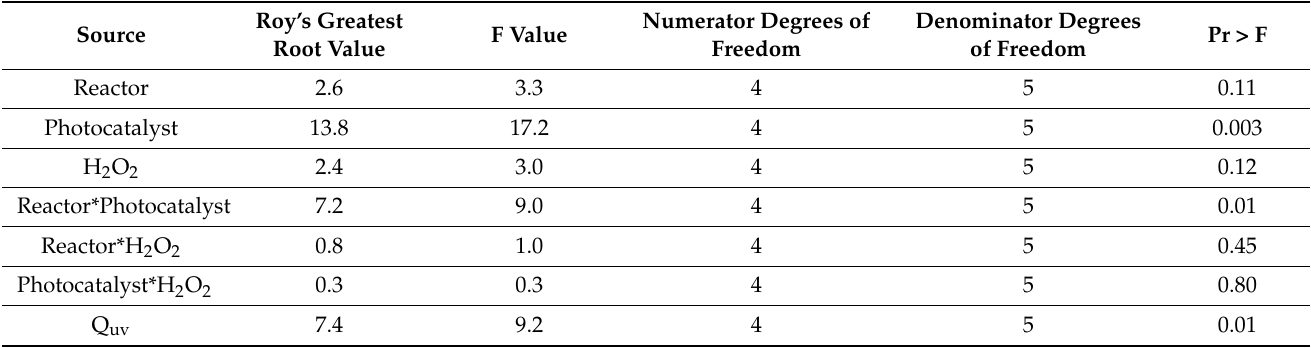
Table 4. Summary of No Overall Effect Multivariate Analysis of Covariance (MANCOVA) for phenol-degradation